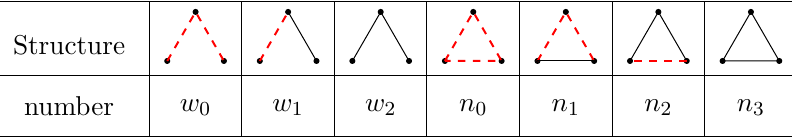
Table 4 . De(cid:12)nition of w 0 ; w 1 ; w 2 and n 0 ; n 1 ; n 2 ; n 3